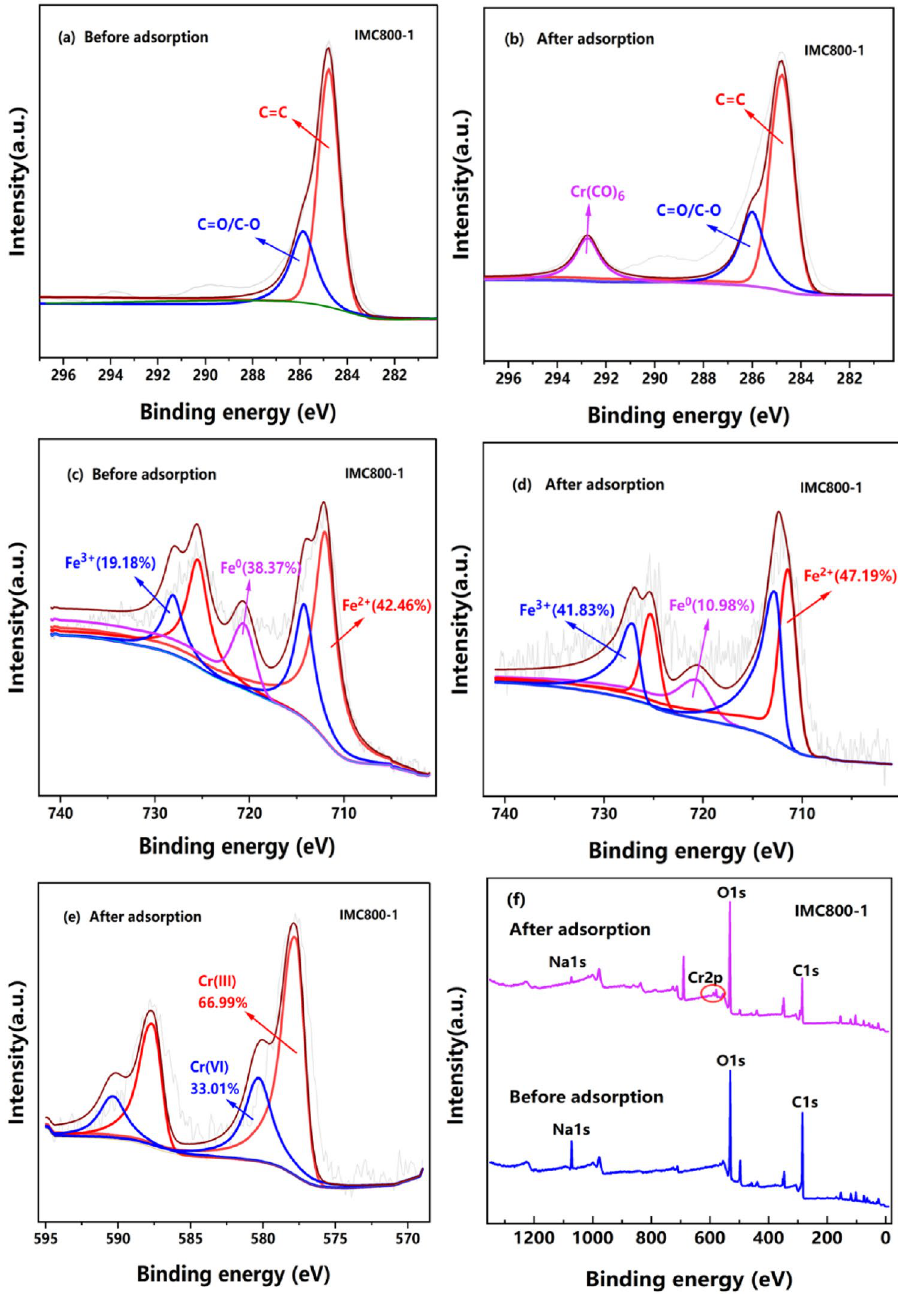
Figure 6. XPS spectra of IMC800-1 before and after Cr(VI) adsorption: ( a ), ( b ) C 1 s, ( c ), ( d ) Fe 2p, ( e ) Cr 2p, ( f ) Full